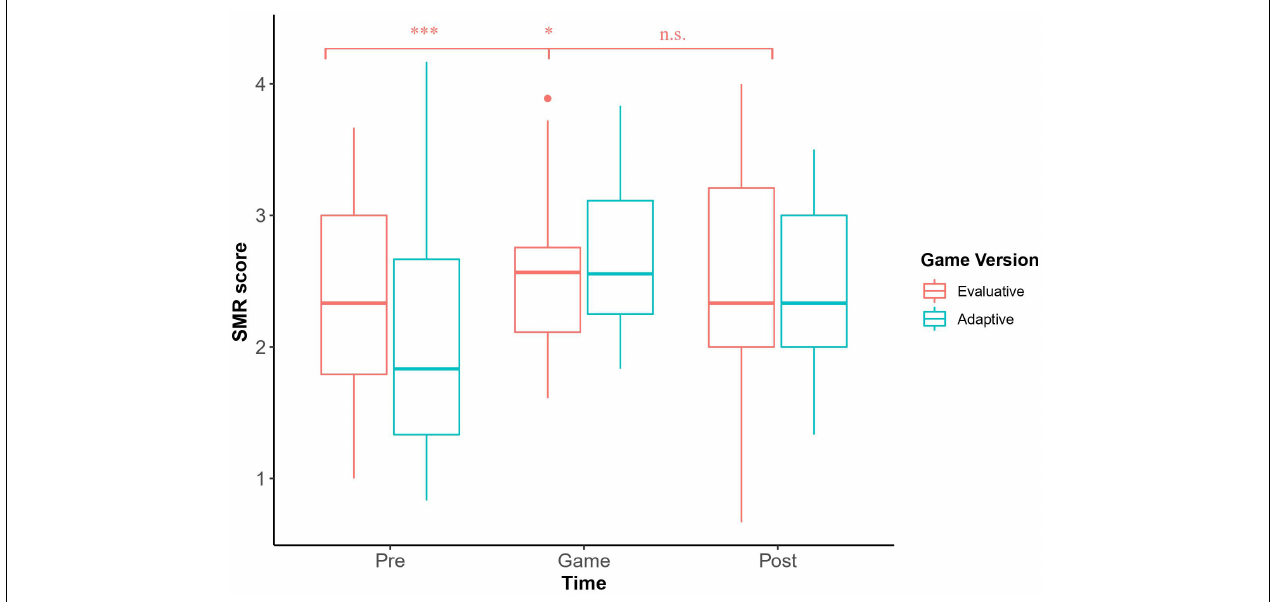
FIGURE 2 | SMR score averages before, during and after the gameplay. As shown above, the average score of the adaptive group significantly increased from pre to in-game and that improvement was maintained to post, whilst the evaluative group’s average score stayed relatively stable throughout the experiment.